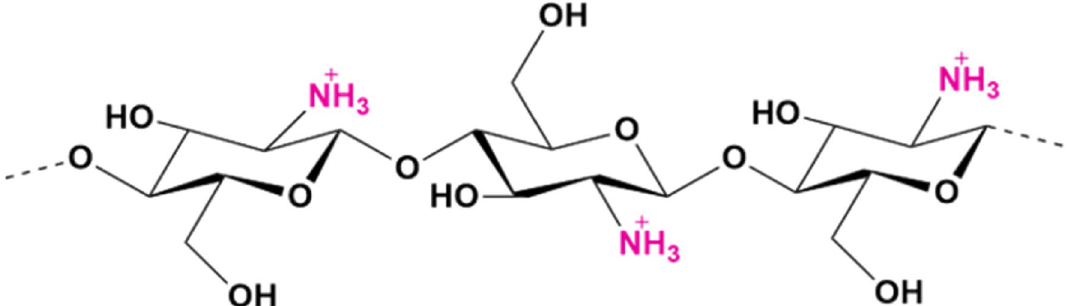
Figure 1. Structure of chitosan with its active amino groups, after their protonation in acid conditions, responsible for the antimicrobial activity (image obtained with